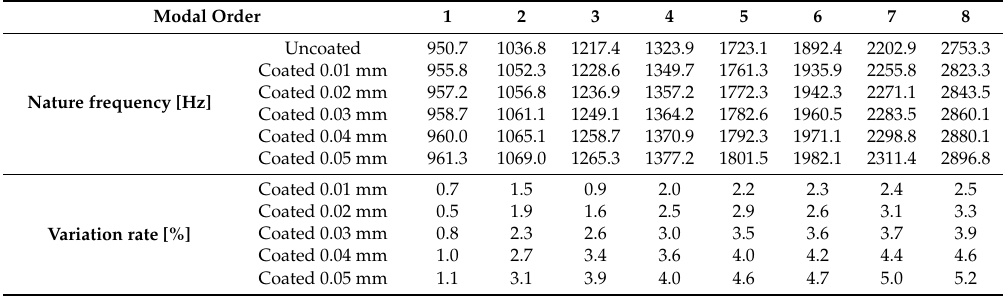
Figure 9. The modal loss factor of the composite shell corresponding to different thicknesses of hard coating. Table 9. The influence of thickness of hard coating on the natural frequency of the composite shell.